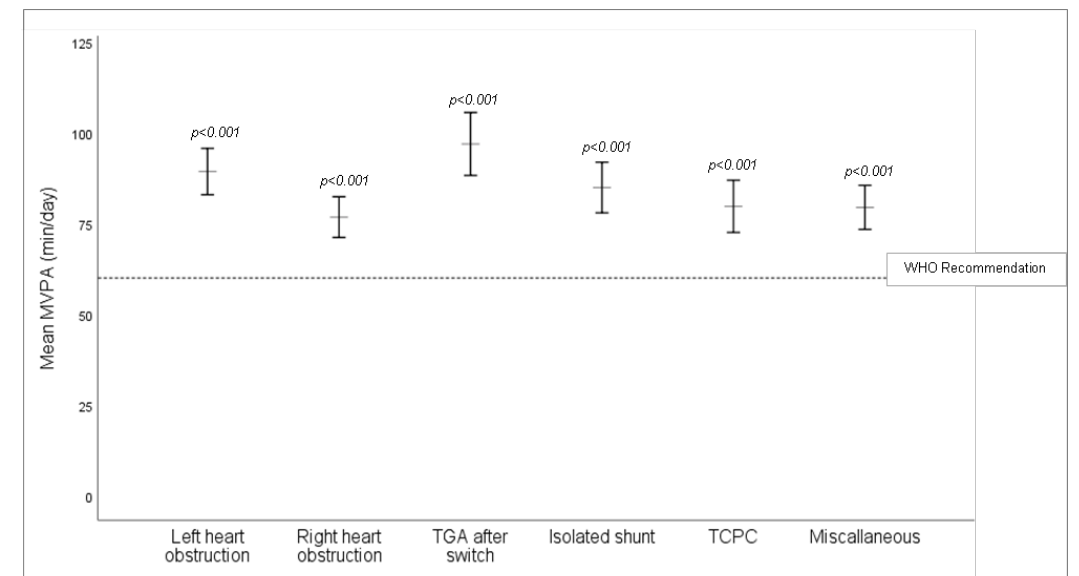
Figure 1. Mean values of MVPA (min/day) between CHD subgroups corrected for age, sex and BMI z-score. All CHD subgroups significantly exceeded the minimum 60 min MVPA per day recommended by the WHO. TCPC = total cavopulmonary connection, TGA = transposition of the great arteries.